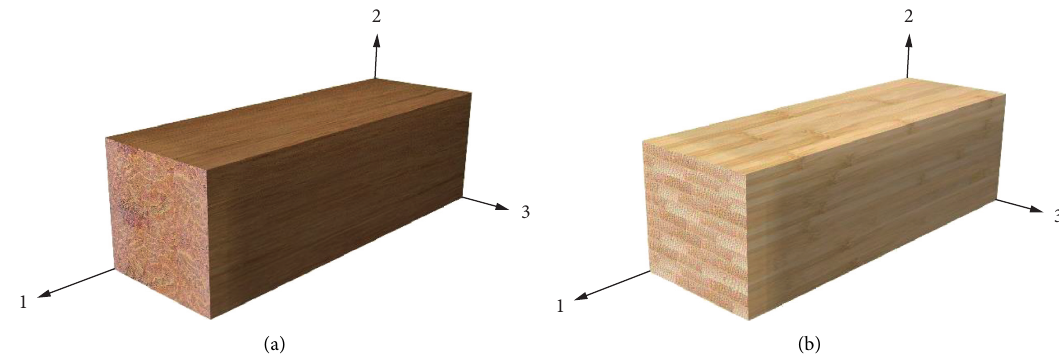
Figure 3: Engineered bamboo composites: parallel strand bamboo (a); laminated veneer bamboo